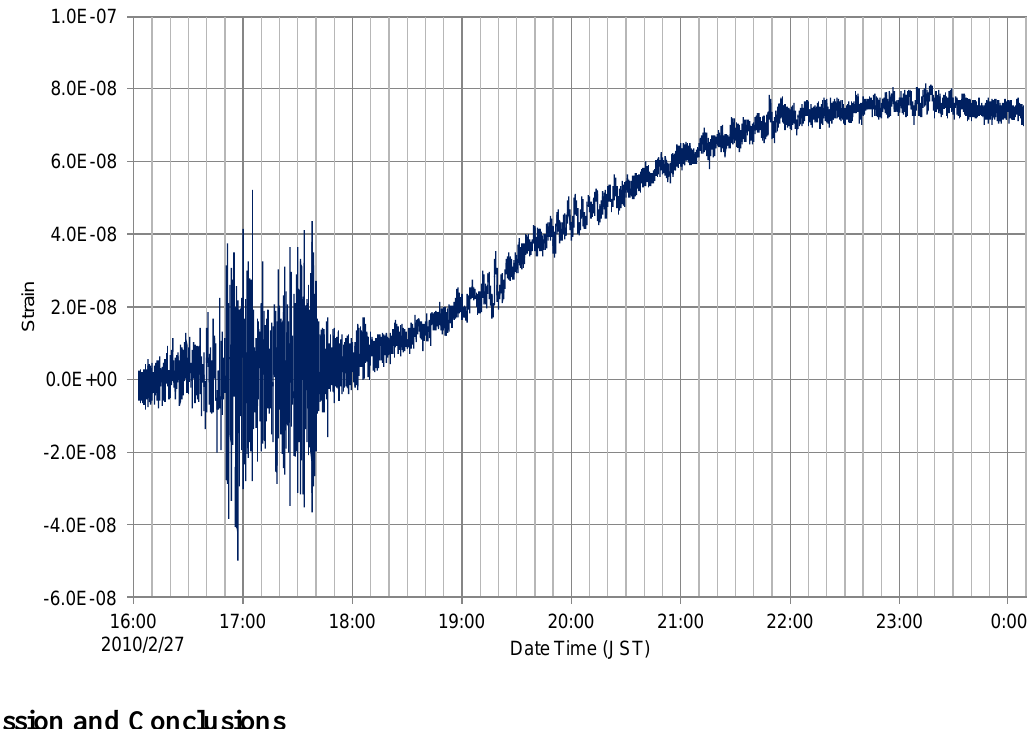
Figure 7. Changes in strain observed by the two-color interferometer when vibrations from a major earthquake in Chile arrived at Kamioka